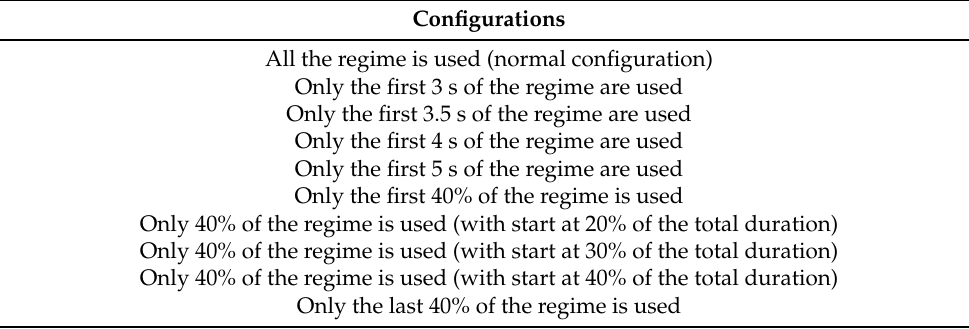
Table 5. Degraded configurations for the computation of the